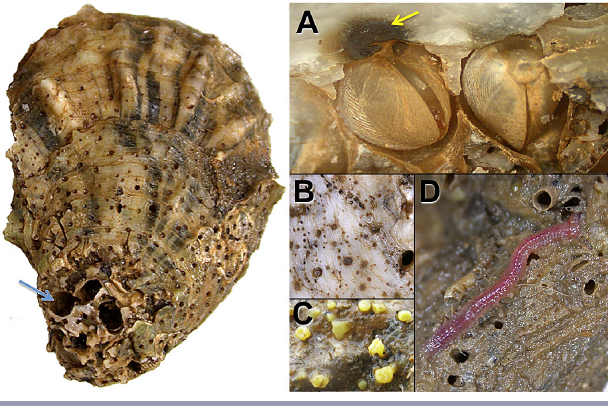
Fig. 5 . Shell parasites observed in Apalachicola Bay oysters 2012-2013. The whole oyster ( Crassostrea virginica ) shell on the left shows evidence of several types of parasite damage. The blue arrow points to one of several larger holes formed by a boring clam ( Diplothyra smithii ). Also evident are numerous smaller holes associated with the boring sponge, Cliona spp. The panels to the right show close up images of common oyster shell parasites. Panel A shows two boring clams seen at the edge of a shell that was fractured to reveal the parasites. Note the black spot (yellow arrow) associated with the clam’s activity on the inner nacreous layer of the shell. Panel B shows close up of exterior shell holes bored by Cliona sponge. In life, this sponge organism is yellow and protrudes from the shell holes (Panel C). Panel D reveals a Polydora polychaete worm on the outside of the shell. This worm forms tubes within the shell, and can cause the oyster host to wall off this invader by laying down nacreous shell on the inside of the shell, sometimes causing “mud blisters.” Photos by Andrew